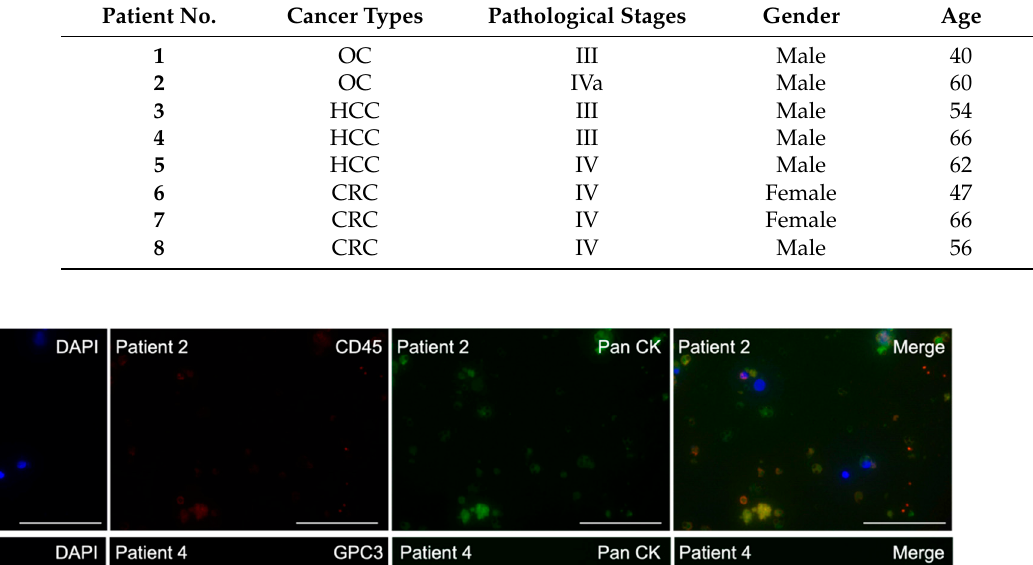
Table 1. Characteristics of cancer patient-derived CTCs.